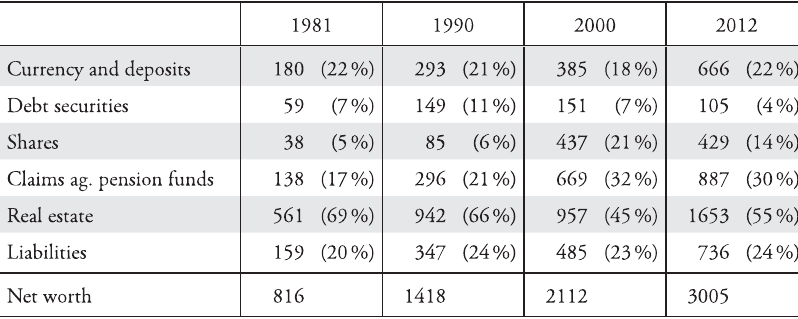
Table 7: Composition of Swiss Household Wealth 1981 1990